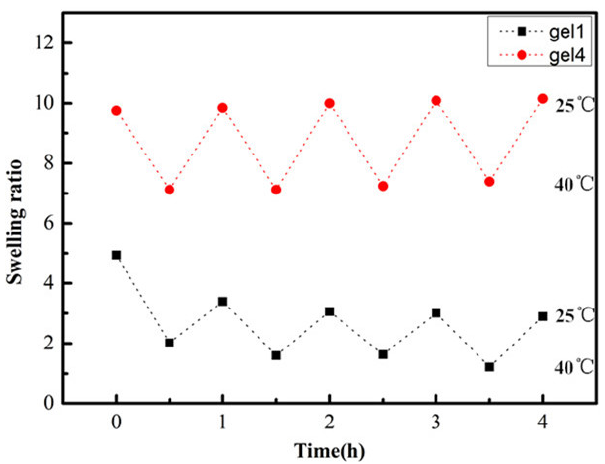
Figure 7. The reversible swelling diagram of gel1 and gel4.